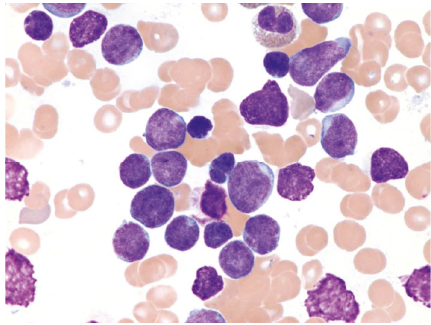
Figure 1: Bone marrow aspirate smear from patient #1, Wright-Giemsa,